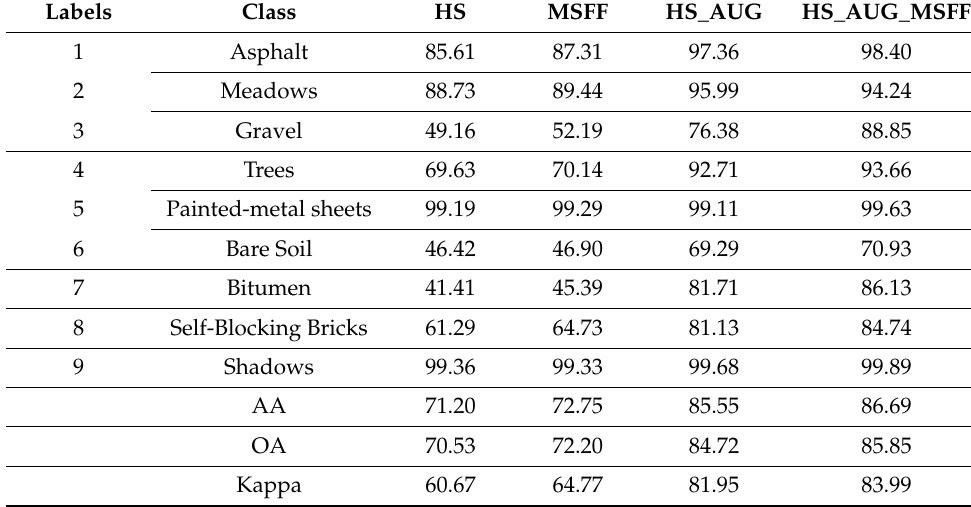
Table 2. Classification accuracies per class (%) of different features by MLR on the PaviaU data.